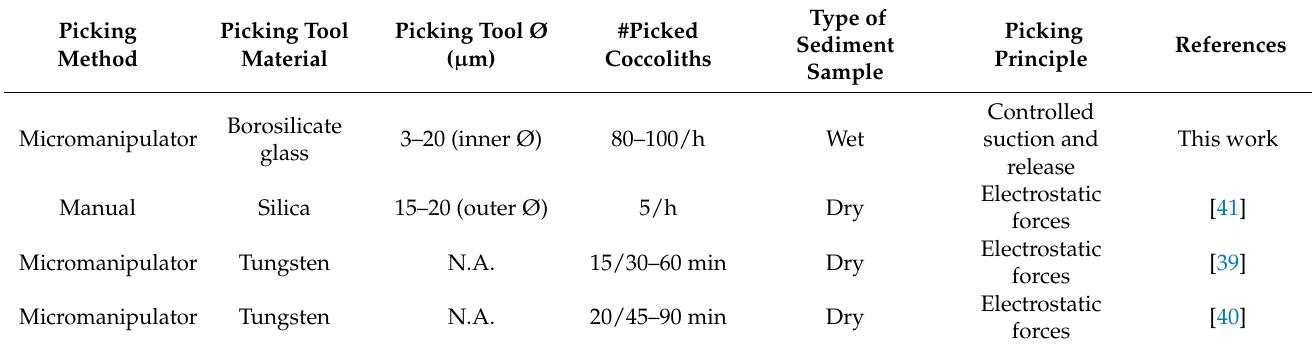
Table 2. Main characteristics of the picking techniques available in the literature compared to this work. N.A.: not available. Hashtag (#) means